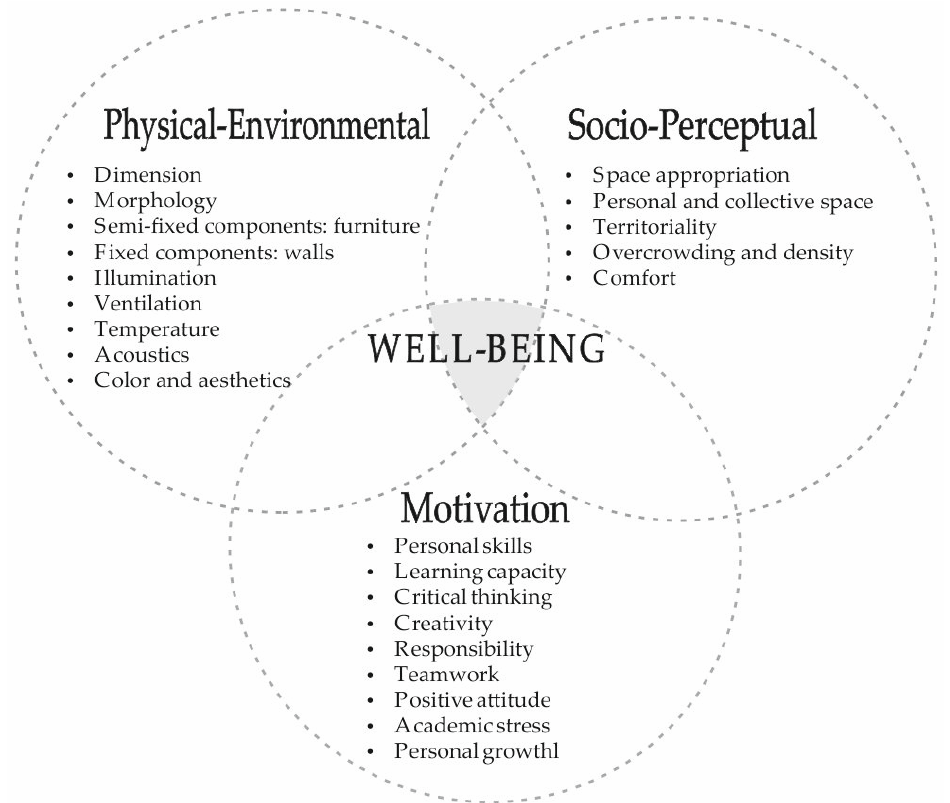
Figure 1. Conceptual structure and dimensions of the impact of the university classroom on managing of the socio-educational well-being of students.